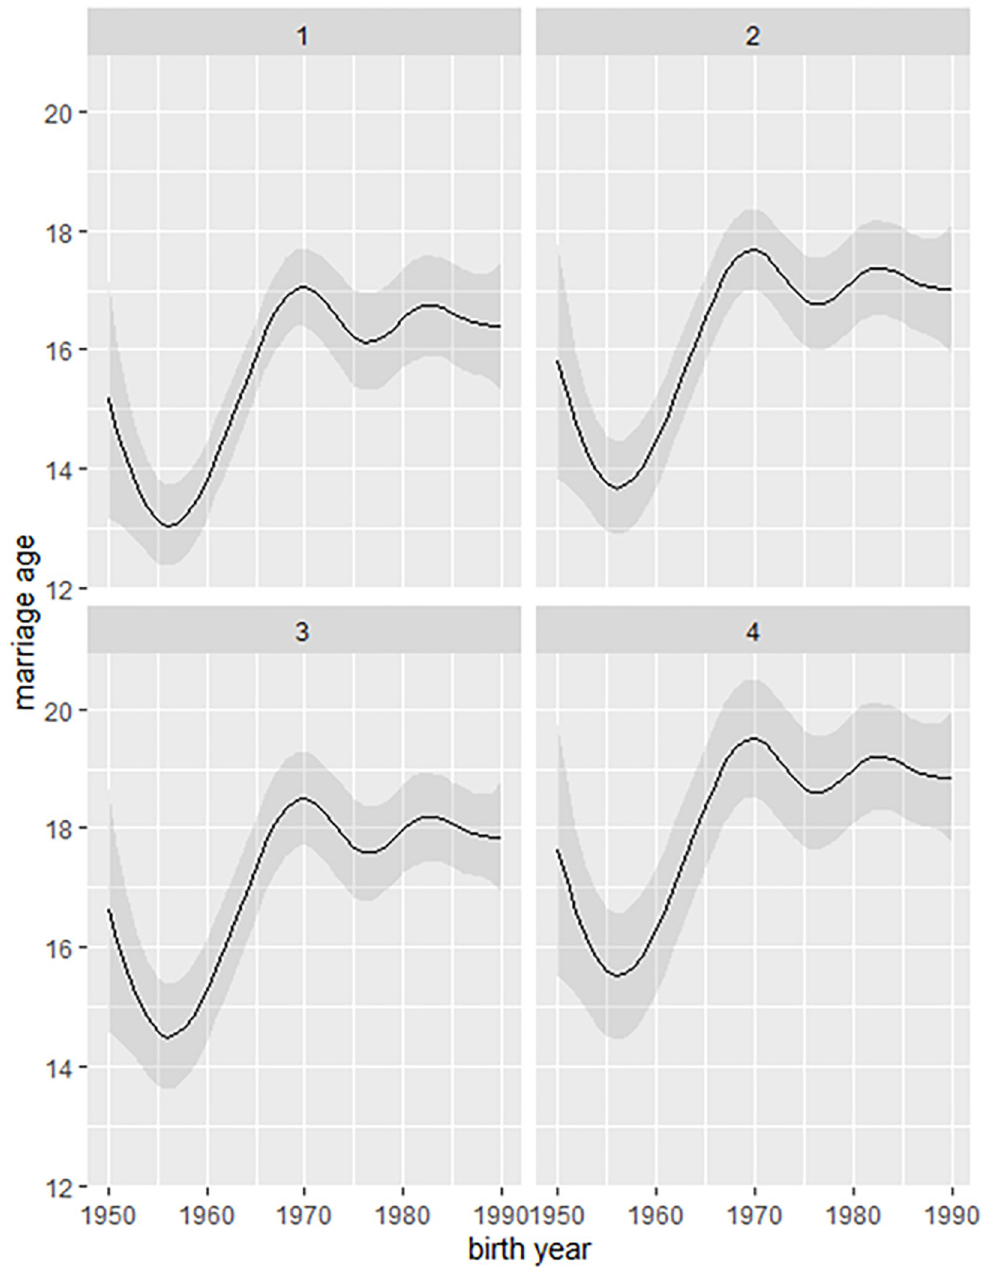
Fig 2. Changes in average ages at marriage according to women’s level of education. The solid lines are the estimated ages at marriage, while the shaded lines indicate the 95% confidence intervals. 1–4 represent women’s level of education: 1– illiterate, 2 –primary (1st–5th standards), 3 –middle school (6th–8th standards), 4 –high school (9th–10th standards), and higher secondary (11th–12th standards). Marriages states that: "(1) Men and women of full age, without any limitation due to race, nationality, or religion, have the right to marry and to establish a family. They are entitled to equal rights as to entering into marriage, during marriage, and at its dissolution; (2) Marriage shall be entered into only with the free and full consent of the intending spouses ( . . . )" [50: 232]. The Convention came into force in December 1964 and obliged states